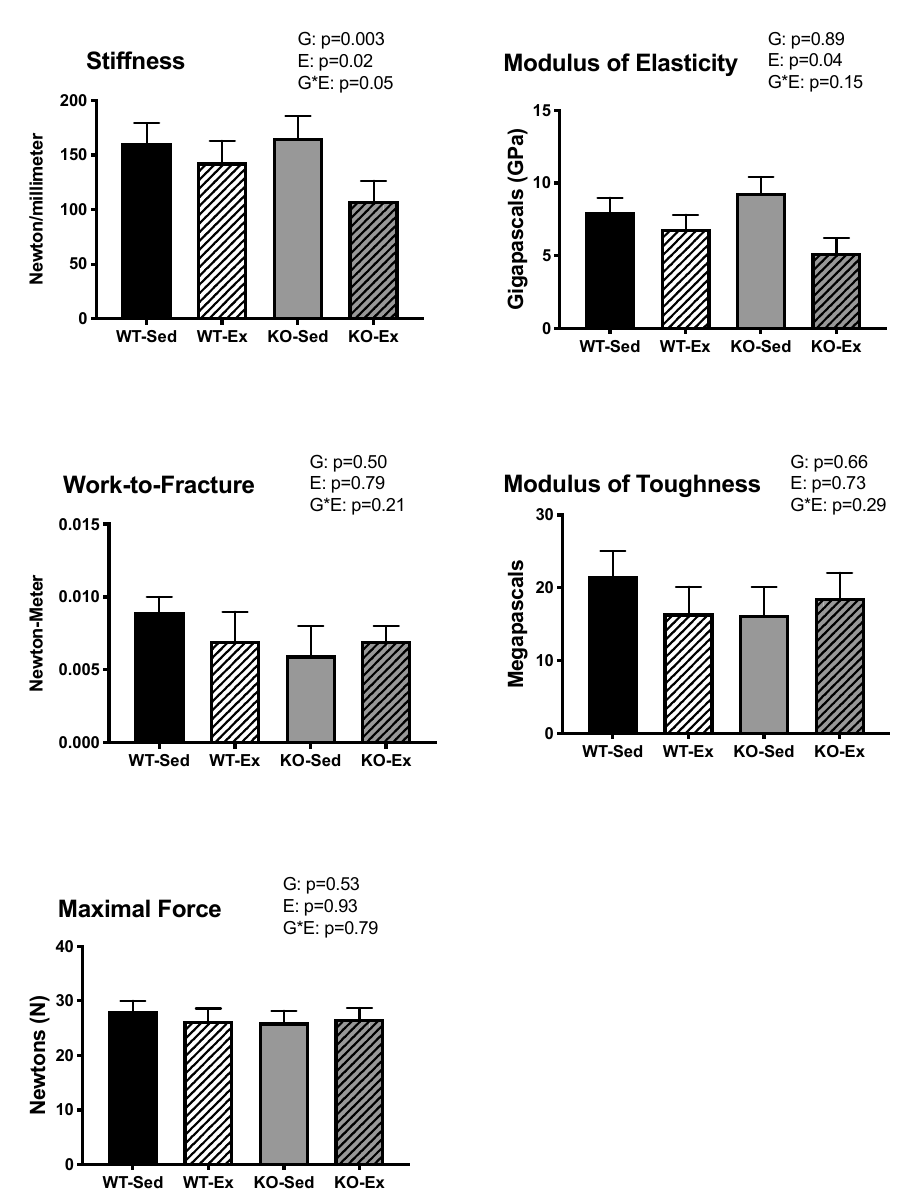
Figure 2. Biomechanical properties. Biomechanical strength of the tibia. Data are adjusted means ± SEM, n = 6–8 per group ERKO: ER α knock out; WT: wild type; Ex: voluntary wheel running; Sed: sedentary. G: main effect of genotype ( p ≤ 0.05); EX: main effect of exercise status ( p ≤ 0.05). There was a significant main effect of EX on Young’s modulus of elasticity ((GPa): Ex = 6.012 ± 0.762; Sed = 8.665 ± 0.762; p = 0.04).